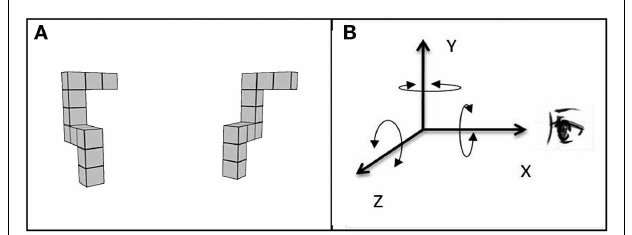
FIGURE 1 | Example of the MR test trial stimulus with (A) showing the subject’s view of the stimulus and (B) showing the three principle axes of rotation, X , Y , and Z , used in the current study. Note that this coordinate frame differs from the one normally used in computer graphics in which the positive Z -direction is perpendicular to the plane of the display, pointing toward the